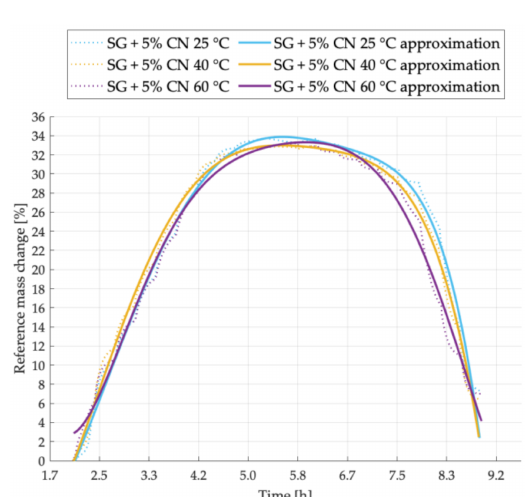
Figure 4. Sorption kinetics graph for SG + 25% Al sample tested at temperatures of 25 ◦ C, 40 ◦ C, 60 ◦ C.